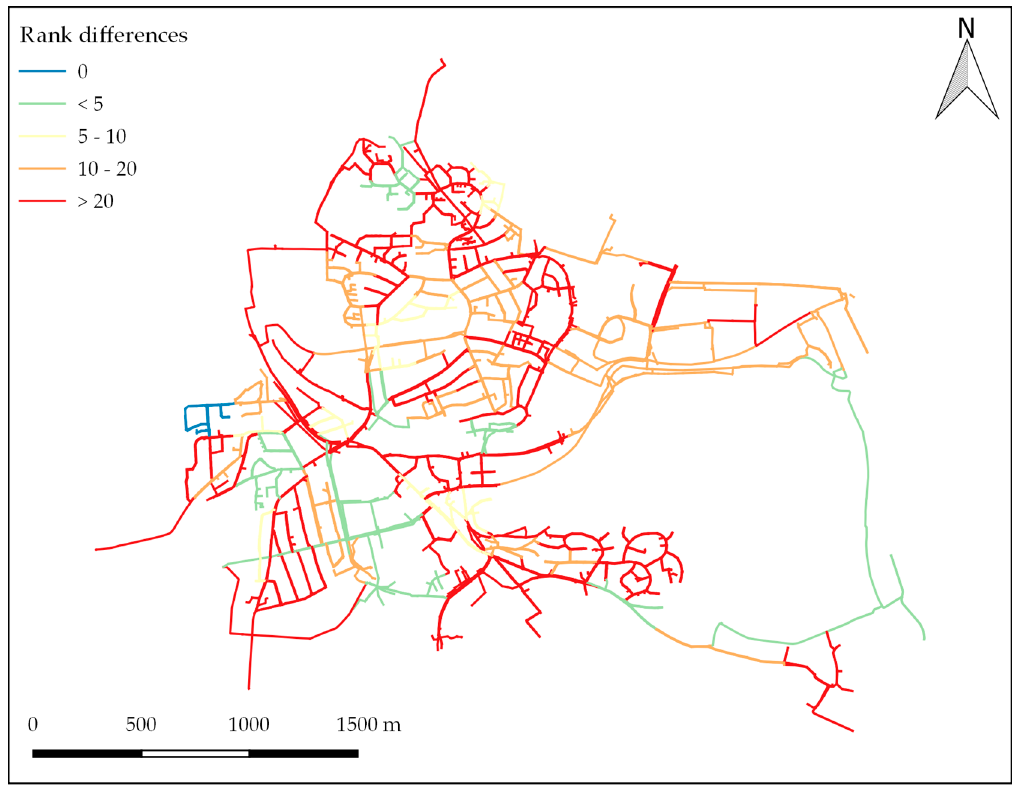
Figure 16. Comparison of the results of the AHP approach with a different approach with different scores [10].